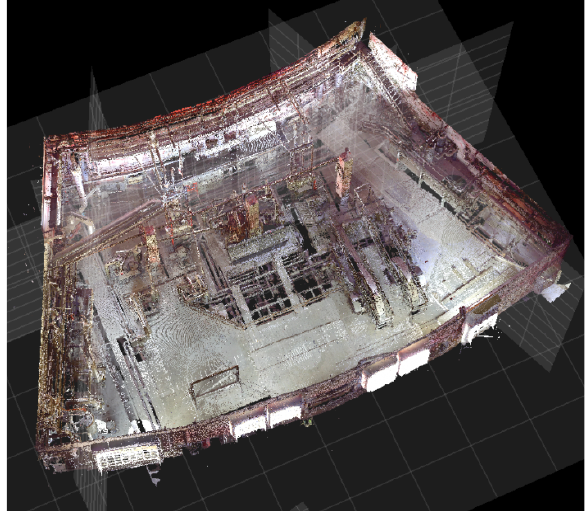
Figure 10. Global 3-D model of the machine room with texture mapping derived from images acquired by scanner.